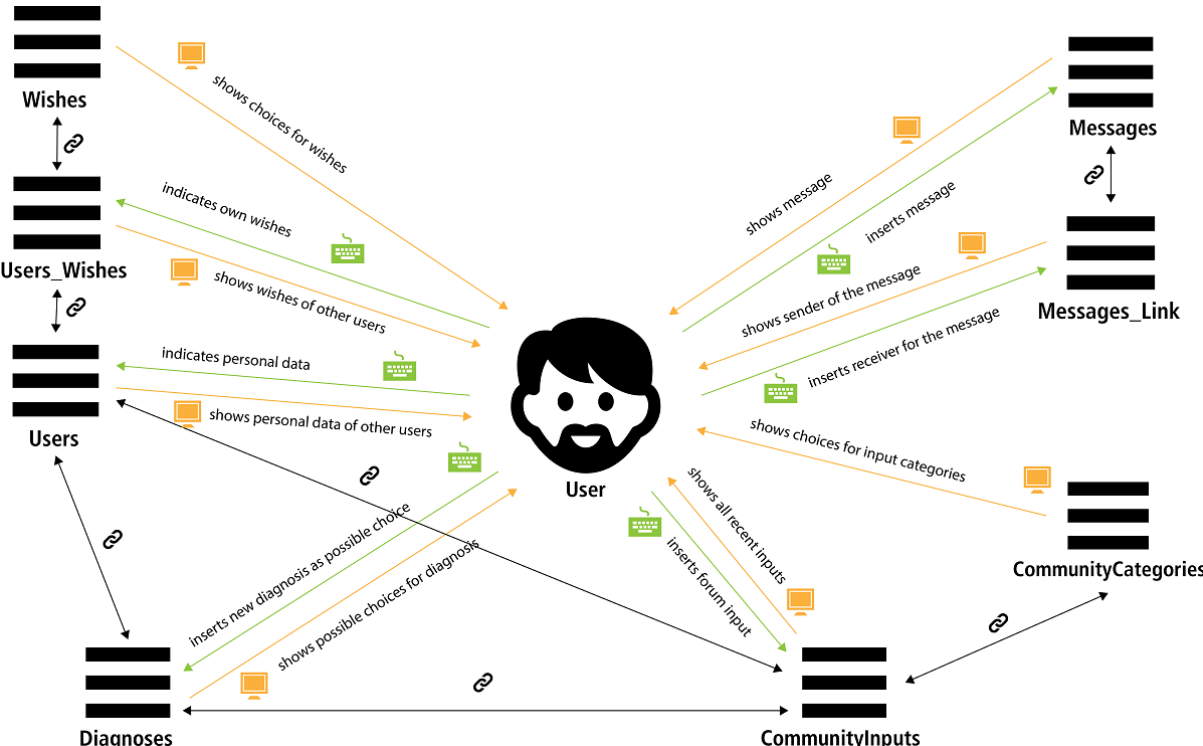
Figure 4. Visualization of the tables and possible interactions between them and the